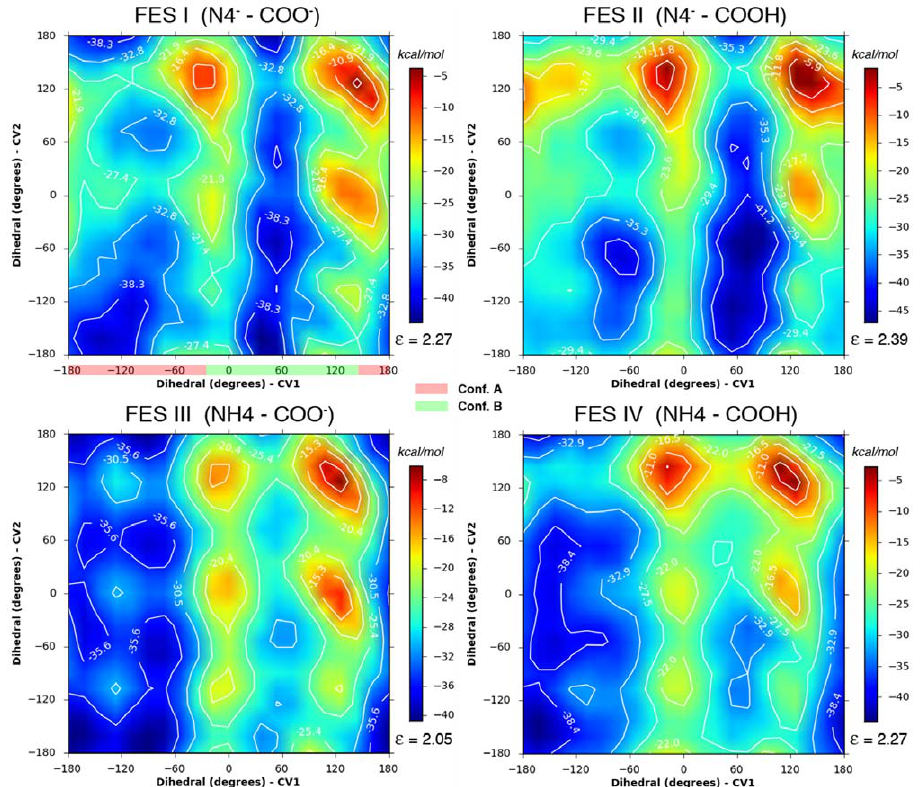
Figure 9. Free energy surfaces (FESs) of the hydroxyethyl group rotations in the enzyme. FESs for the hydroxyethyl group rotations occurring with hydrolyzed biapenem in the active site of CphA in the configuration No. 4 of Table 1 were calculated under the same conditions and for the same collective variables as in Fig. 8 . The start point for all simulations was conformation B. The start point for all simulations was conformation B. The average error e (kcal/mol) of the FES, as calculated from equation (4) (see Methods) is shown in each panel below the color bar.